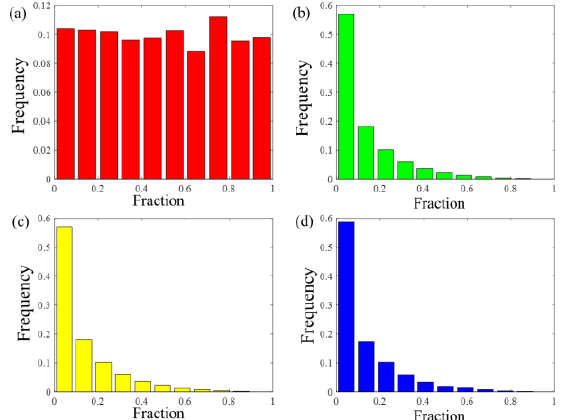
Fig.3 The distribution of generated fractions: (a) NPV; (b) PV; (c) soil; (d) snow.